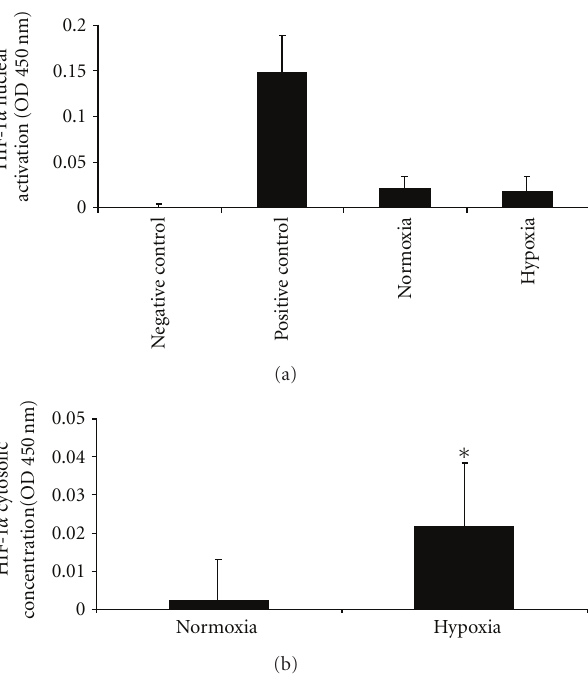
Figure 5: (a) Nuclear HIF-1 α activity of PBMC under normoxia and after hypoxia. (b) Cytosolic HIF-1 α concentration in PBMC. n = 14, data are expressed as mean ±